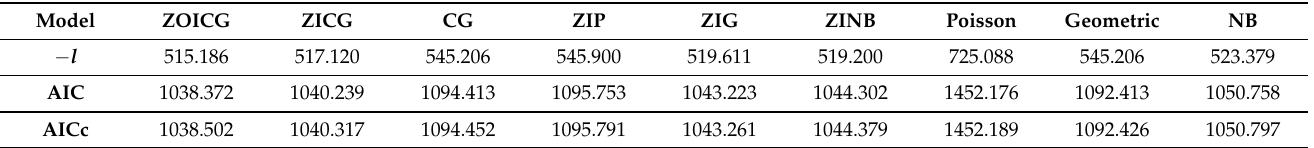
Table 5. The log likelihood, AIC, and AICc values of different models.